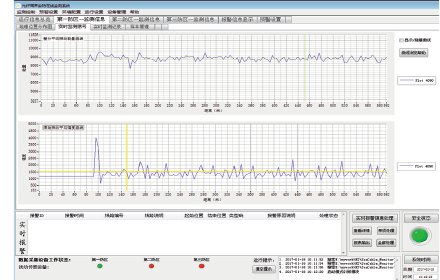
Figure 13: Distribution of differential short-time energy and av- erage vibration amplitude of original vibration signals.